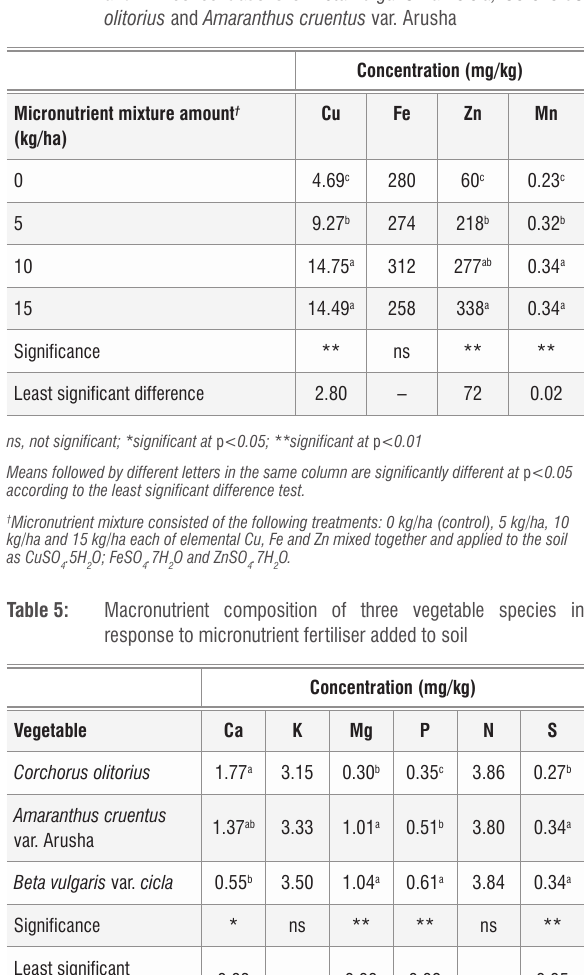
The main effect of soil-applied micronutrients on leaf Cu, Fe, Zn and Mn concentrations of Beta vulgaris var. cicla, Corchorus